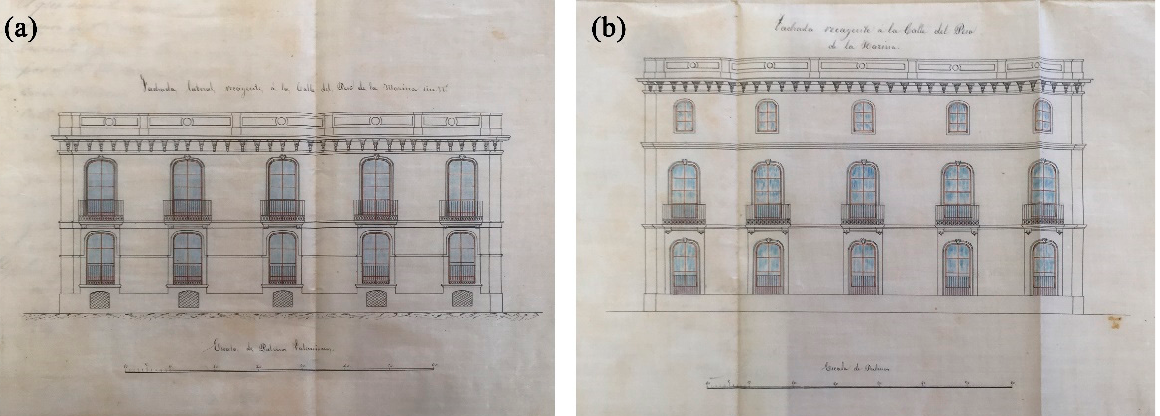
Figure 2. ( a ) First proposal for the western façade, dated June 1863. Semi-basement, ground floor and main floor (this solution was not built); ( b ) Second project proposal for the western façade, dated December 1863. Ground floor and two floors. Architect Manuel Ferrando. Municipal Histor- ical Archive of Valencia, Urban Police box No. 97, year